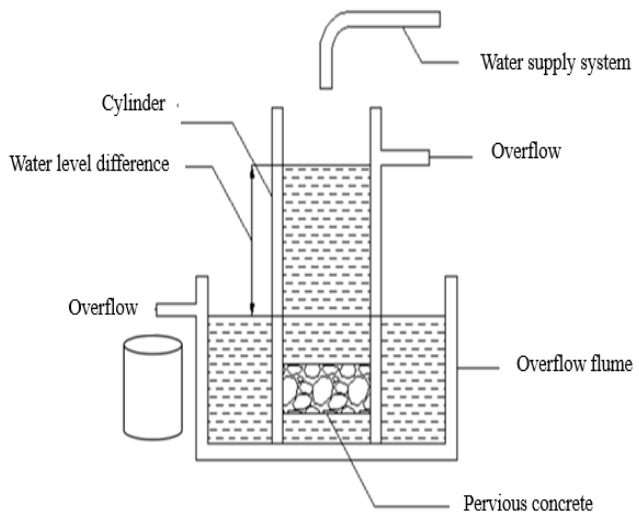
ffi cient test set